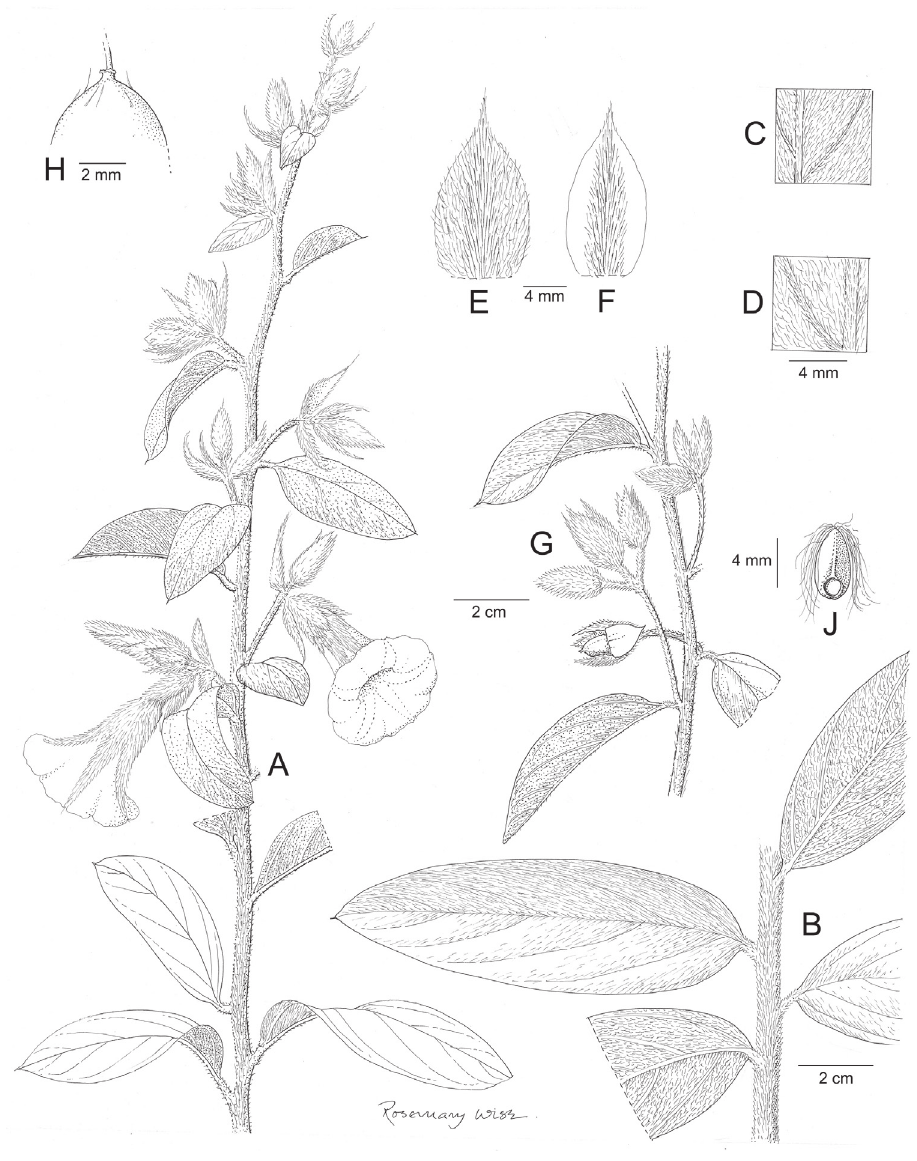
Figure 6. Ipomoea dasycarpa. A habit B leaves and stem C adaxial leaf surface D abaxial leaf surface e outer sepal F inner sepal G fruiting inflorescence with fallen bracteoles h apex of capsule J seed. Drawn by Rosemary Wise: A–D from J.R. Pirani et al. 1715, e–F, h, J from H.S. Irwin et al. 32875, G from H.S. Irwin et al.